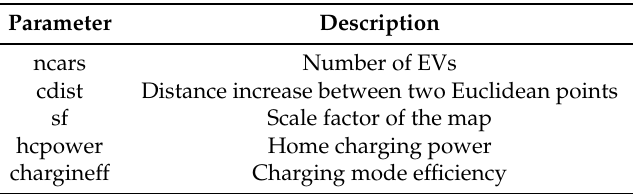
Table 1. Global simulator parameters.